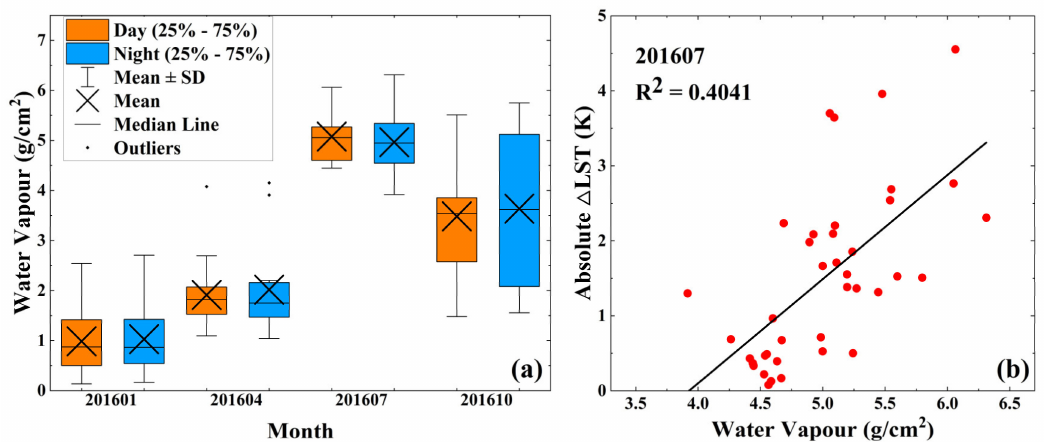
Figure 6. ( a ) The daily average water vapor content (WVC) of the ERA5 atmospheric reanalysis product (used for AHI LST retrieval) in four months at the TH site and ( b ) the AHI LST absolute error versus the daily average WVC at the TH site in July